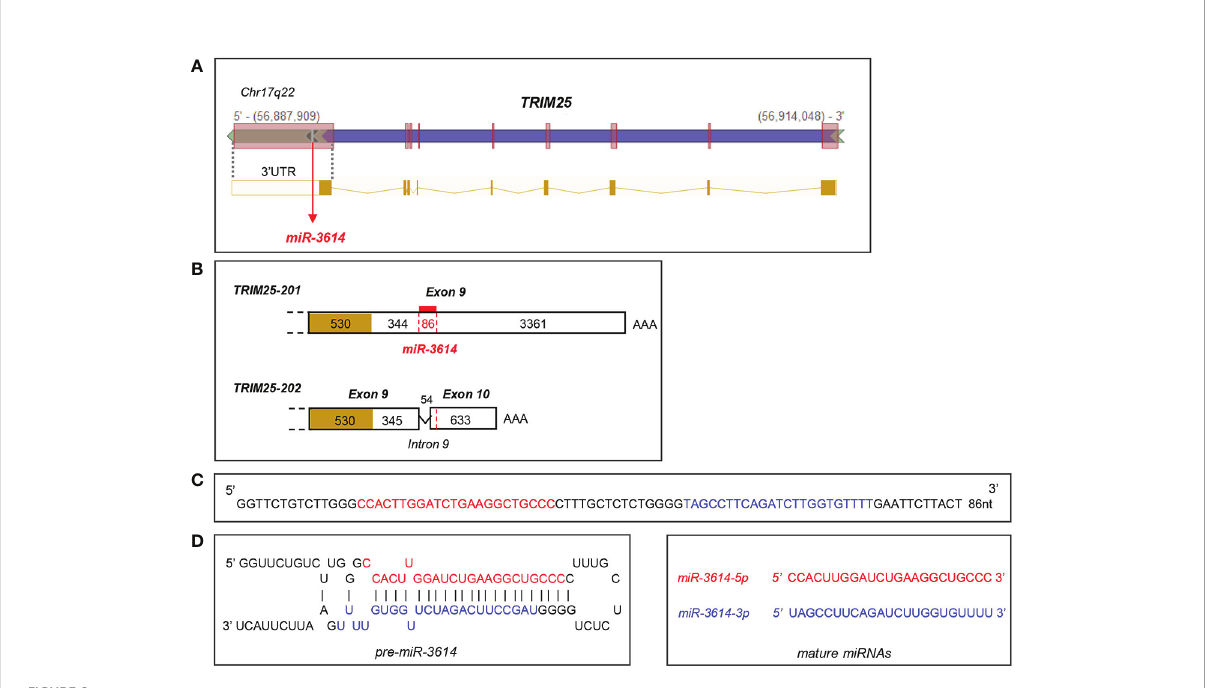
FIGURE 2 Localisation and sequence of miR-3614 . (A) Genomic position of miR-3614 sequence in the human TRIM25 gene (from Intragenic microRNA database, miRIAD). (B) Localisation of miR-3614 in the 3 ’ UTR of TRIM25 . Only the last exon(s) of the two protein-coding transcripts, TRIM25- 201 and TRIM25-202 , is shown. The coding region is yellow-coloured and the 3 ’ UTR is white-coloured. In red the 86 nt miR-3614 sequence that overlaps an intronic splice site. (C) The 86 nt miR-3614 sequence. (D) Secondary structure prediction of the miRNA precursor. MiR- 3614-5p and -3p in red and blue,